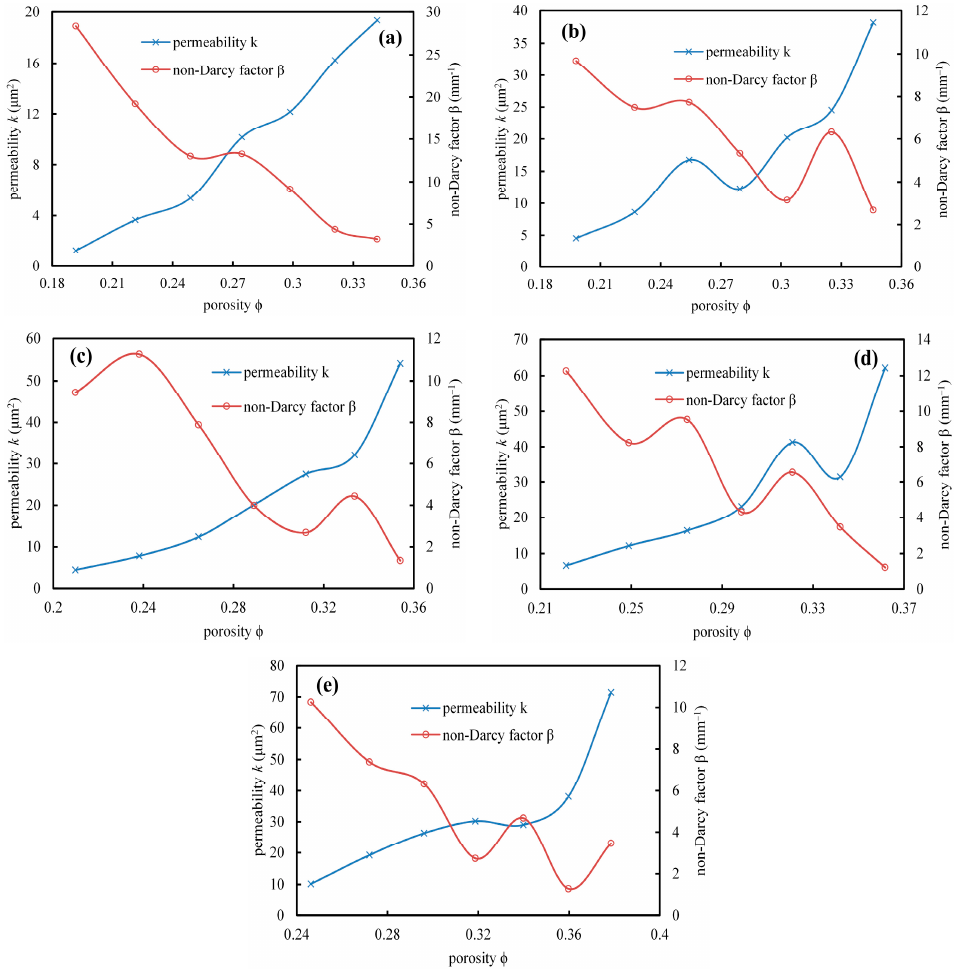
Figure 15. Non-Darcy flow characteristics for the samples at various porosities: ( a ) uniform sample; ( b ) smallest sample; ( c ) smaller sample; ( d ) larger sample; and ( e ) largest sample